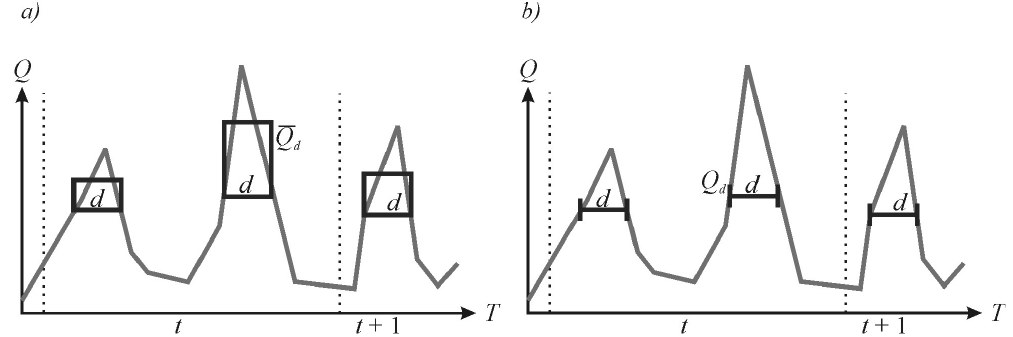
Fig. 3. Definition of the random variables in the QdF models: (a) the mean maximum d days flow, (b) the annual maximum flow discharge ( Q d ) continuously exceeded during the period d